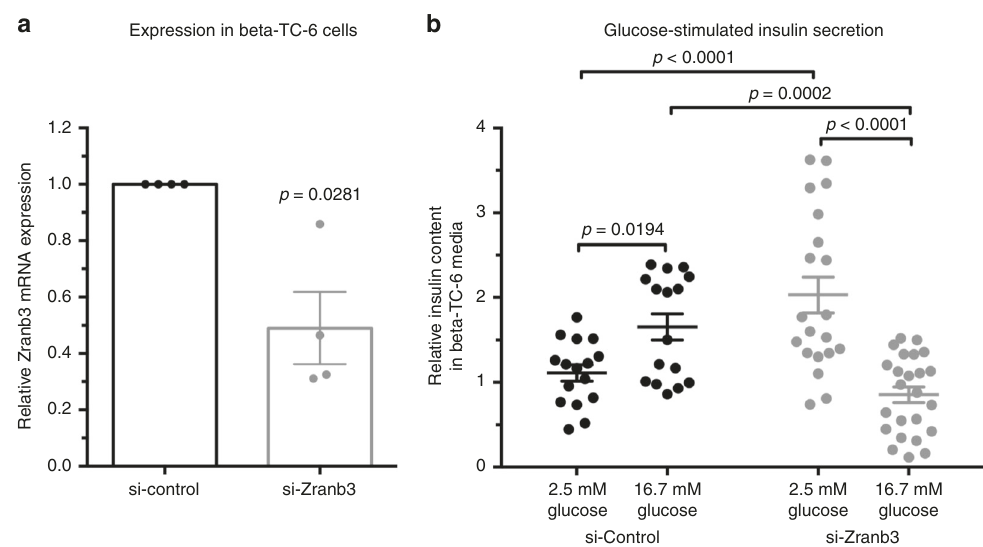
Fig. 6 Suppression of Zranb3 in MIN6 β -cells impairs insulin secretion in response to glucose. a Reduced Zranb3 expression upon treatment of MIN6 cells with siRNA targeting Zranb3 ; n = 4 independent experimental replicates for each, each dot representing independent experiment and bars represent average values across experiments. b Quanti fi cation of total insulin secreted by MIN6 cells into culture media upon low- (2.5 mM) and high-(16.7 mM) glucose conditions. n = 16 – 24 replicates for each experiment and averages across experiments indicated. Error bars represent SEM